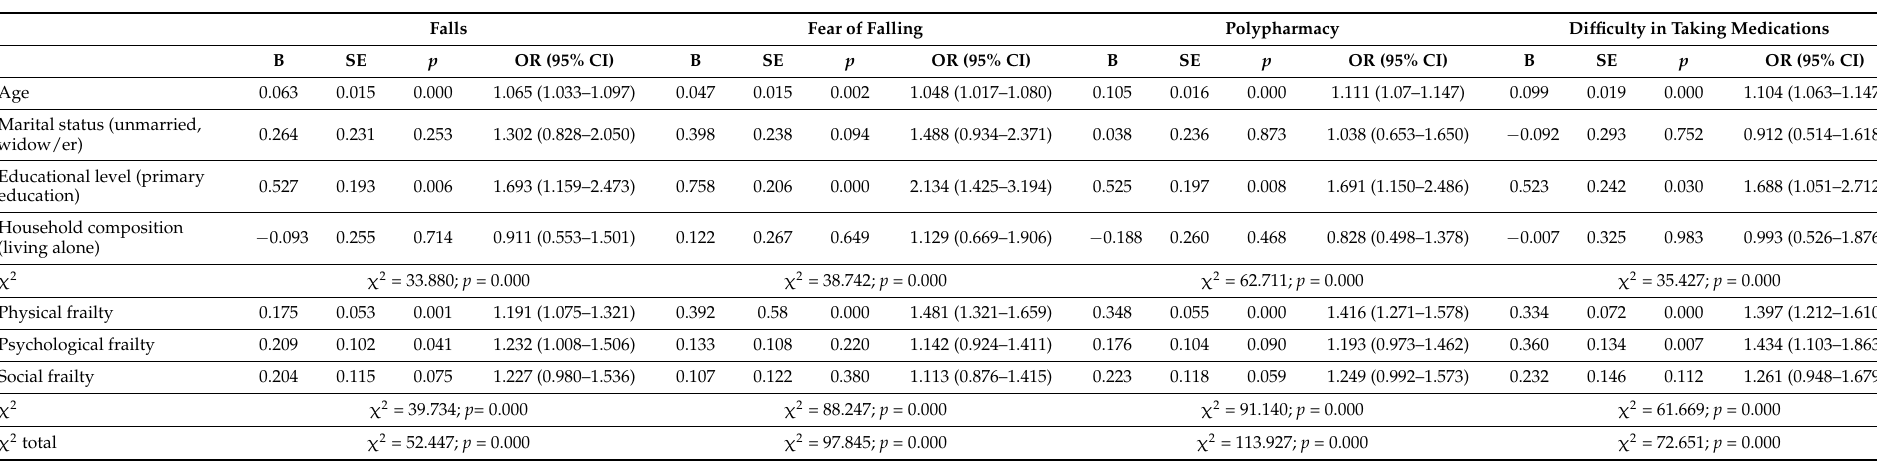
Table 6. LONGITUDINAL Effects of Socio-demographic Characteristics and Frailty Domains on Adverse Outcomes: Logistic Regression